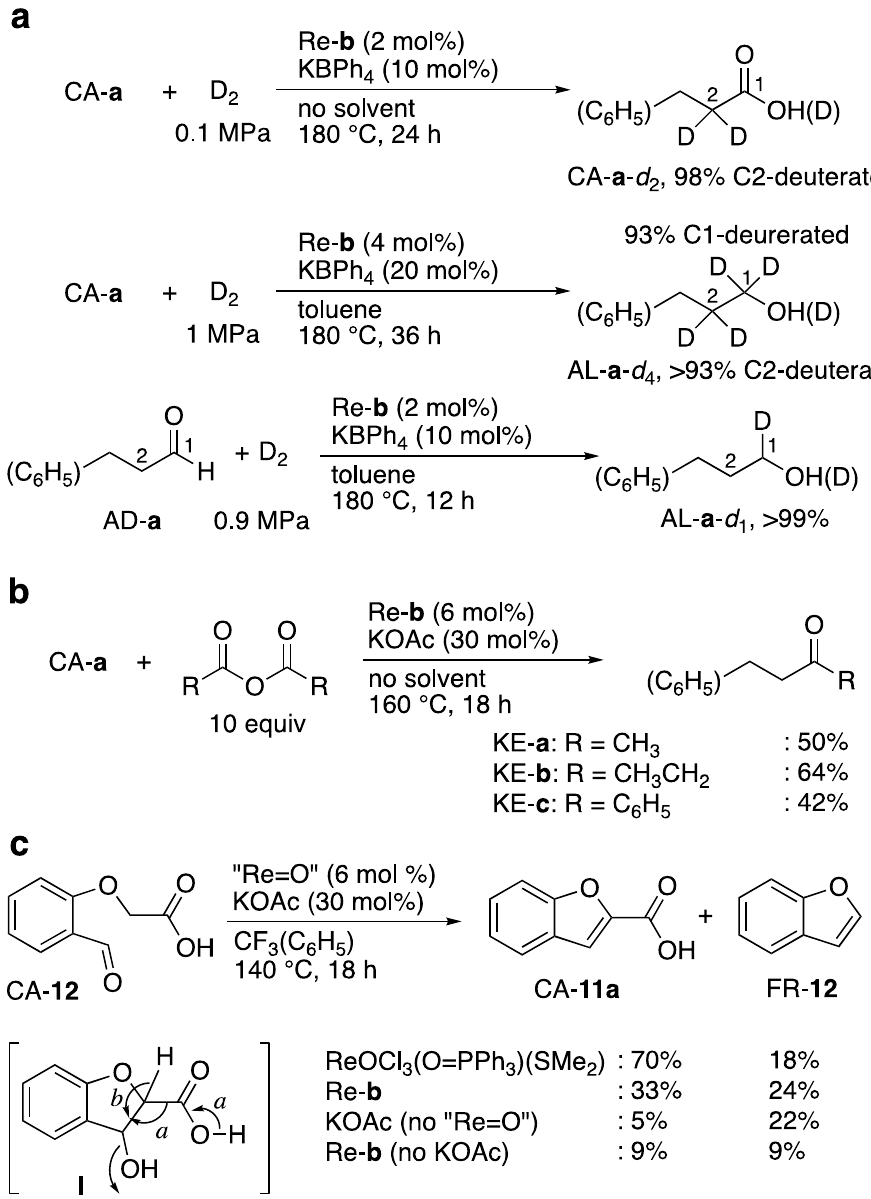
formation in acid anhydrides to afford ketones. ( c ) Intramolecular aldol condensation. a : Decarboxylative dehydration; b : Second deprotonation followed by